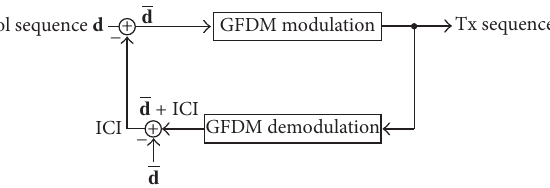
Figure 10: Transmitter side ICI reduction brock diagram.